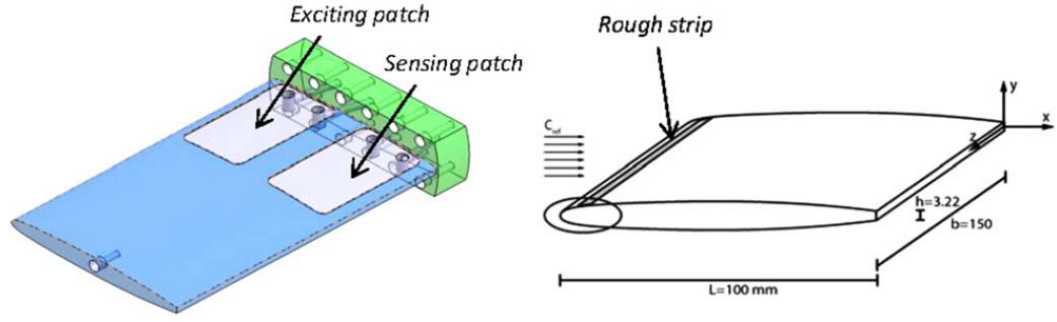
Figure 1. Piezoelectric (PZT) patches installed in a cavitating hydrofoil in order to obtain its natural frequencies [22].